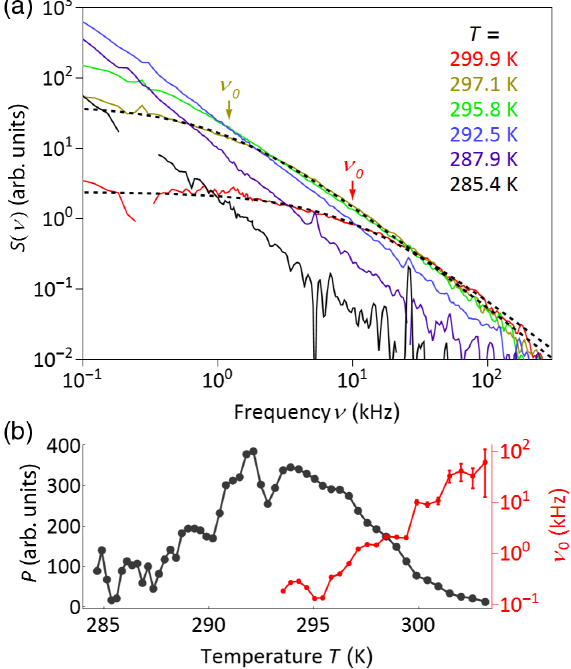
FIG. 3. (a) Magnetization noise spectra S ð ν Þ at different temperatures T , measured at a fixed location on the trilayer that exhibits perpendicular magnetization at low temperatures ( T < 290 K), and in-plane magnetization at high temperatures ( T > 300 K). S ð ν Þ exhibits robust ν − 3 = 2 power-law behavior at low T . With increasing T , S ð ν Þ grows in magnitude but then develops a steadily increasing critical frequency ν 0 , below which the noise tends toward spectrally flat. Again, all spectra can be empirically fit by S ð ν Þ ∝ ð ν þ ν 0 Þ − 3 = 2 (dashed lines). (b) Inte- grated noise power P and critical frequency ν 0 versus T , indicating that the SRT region has been temperature tuned through the fixed location of the probe.